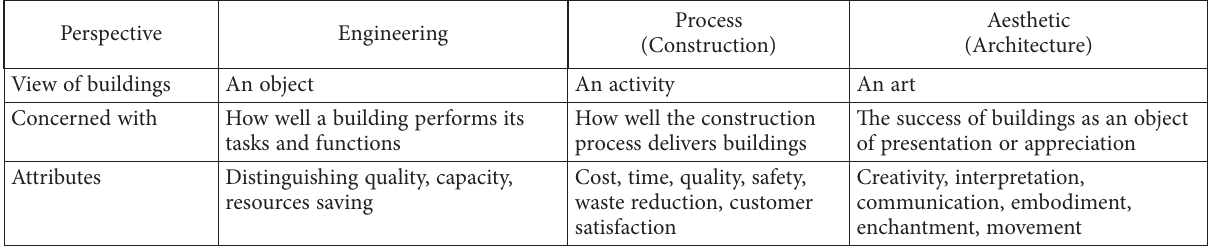
Table 4. Viewpoints and attributes of building performance (adapted from de Wilde, 2017, 2018)